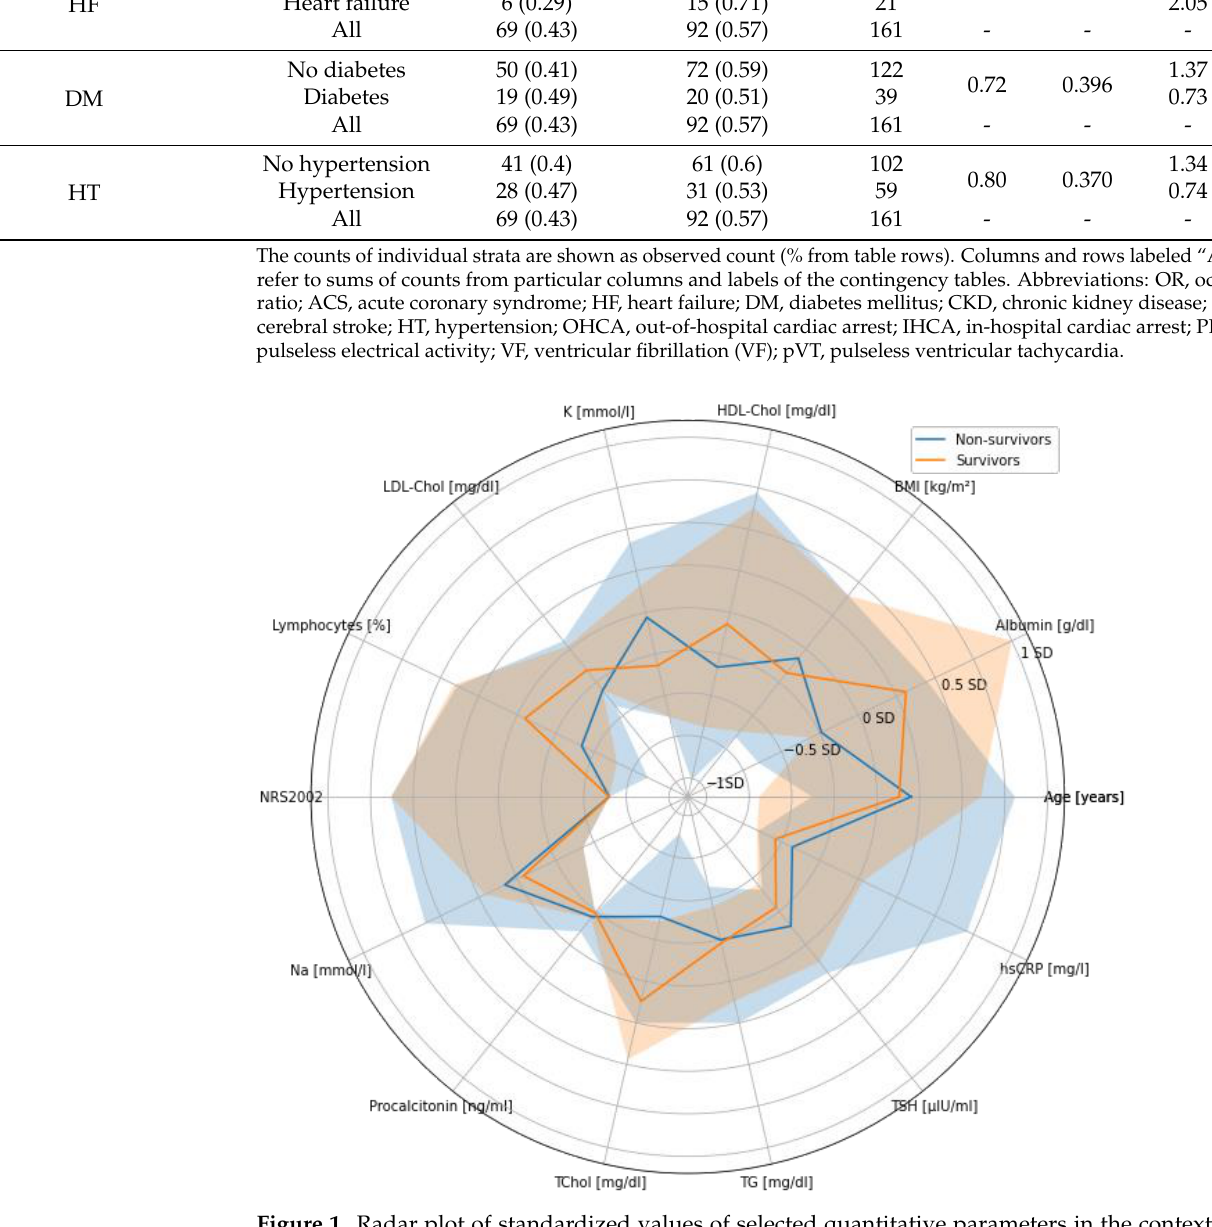
Table 5. Differences between non-survivors and survivors (categorical variables). Variable